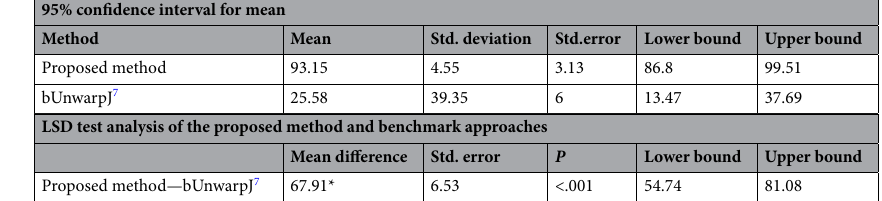
Table 3. Results on the breast cancer dataset in comparison of the proposed method and the best performed benchmark approach in the first experiment. *The proposed method is significantly better than the benchmark approach ( p < 0.001 )